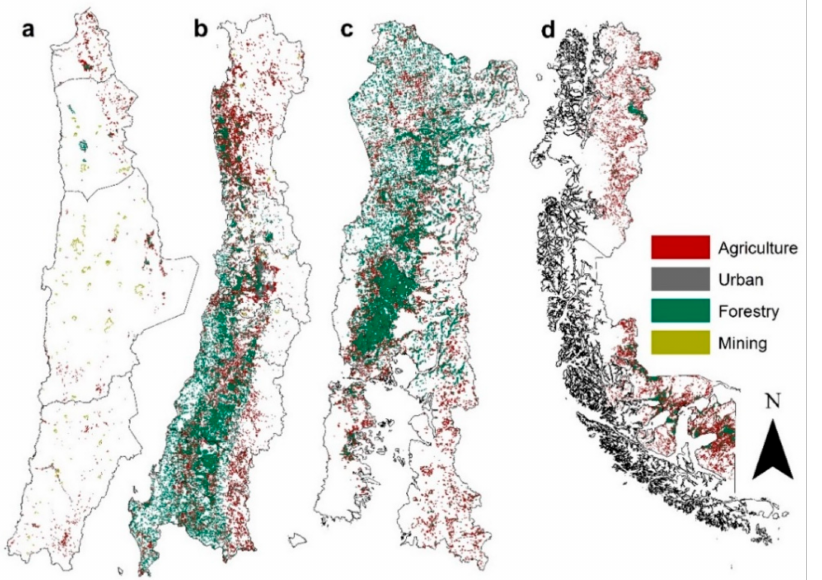
Figure 4. Simulated LULC transitions between categories for the period 2011–2080. North ( a ), Central ( b ), Central South ( c ), and Austral ( d